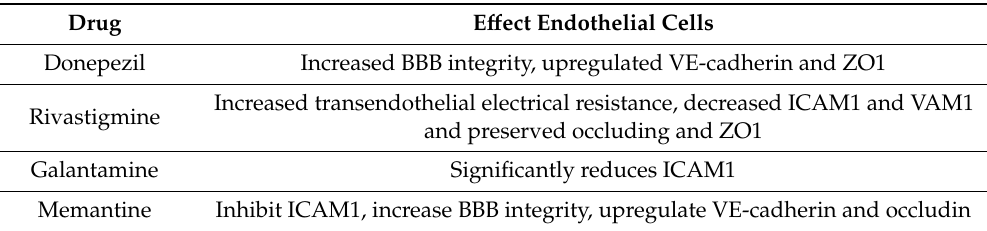
Table 8. E ff ect of current AD drugs on endothelial cells of the BBB.